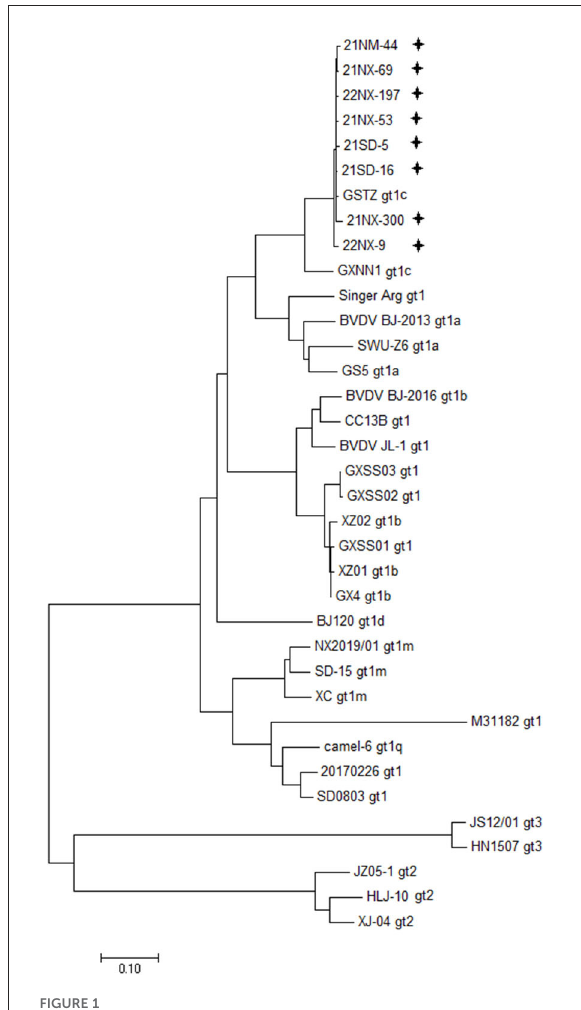
FIGURE1 Phylogenetic analysis based bon the whole genome. A phylogenetic tree was created using the whole genomes of eight BVDV isolates and 28 reference strains retrieved from the GenBank database. “ + ” BVDV isolates identified in the four provinces in this study. All isolates were clustered in